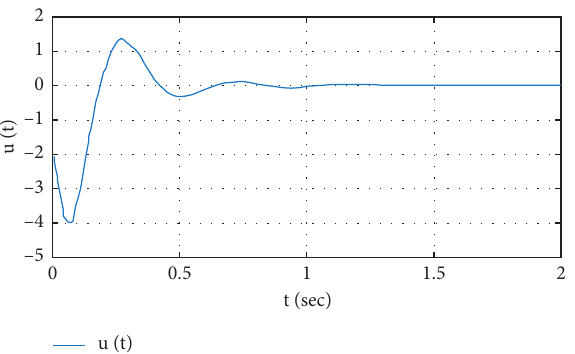
Figure 4: Time response of control input.